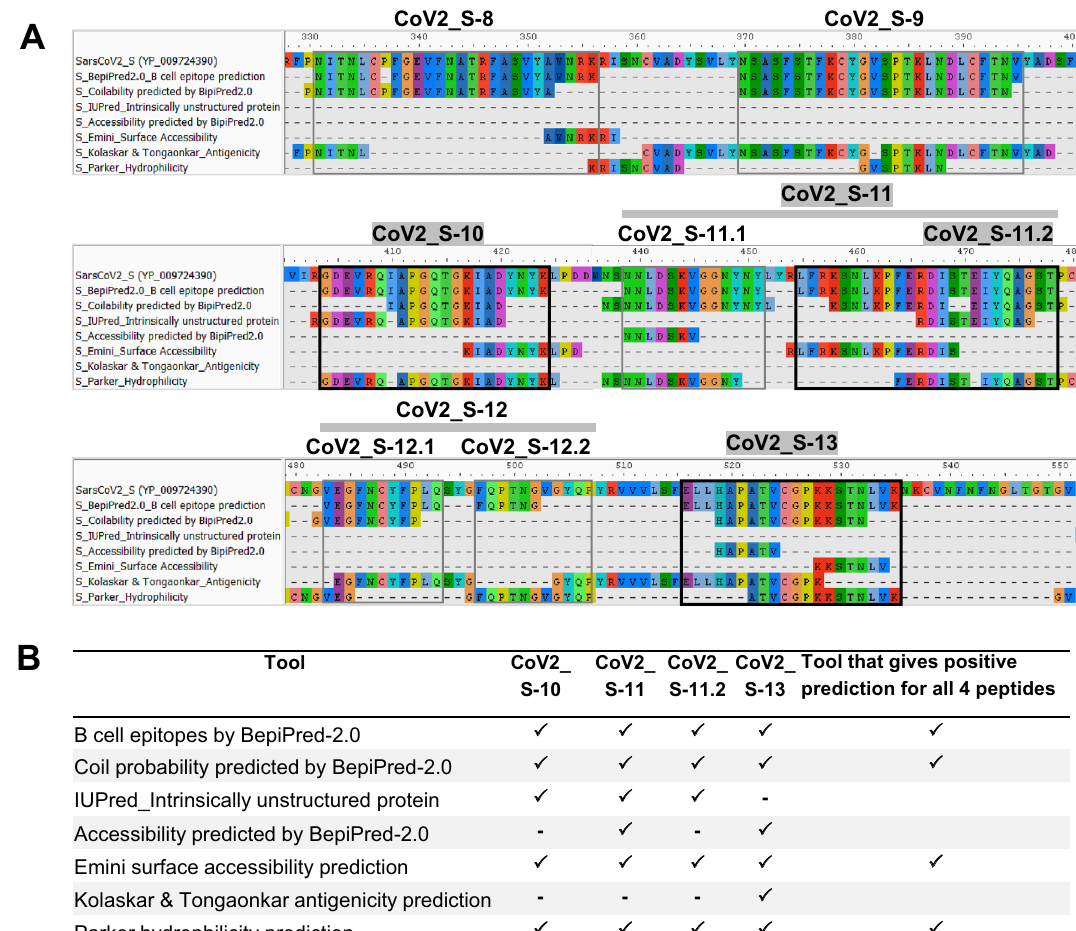
Figure 4. Characterization of the immunodominant epitopes using multiple immunoinformatics tools. In addition to linear B cell epitope prediction with BepiPred-2.0, the entire sequence of the SARS-CoV-2 RBD was predicted for coil structure, accessibility, antigenicity and hydrophilicity using the prediction tools as indicated. ( A ) Alignment of the sequences obtained from each prediction tool. The immunodominant epitopes are indicated (thick box). ( B ) Determination of common characteristics of the three immunodominant